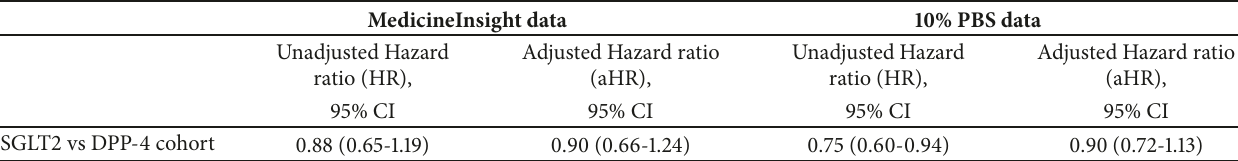
Table 4: Risk of UTIs. MedicineInsight